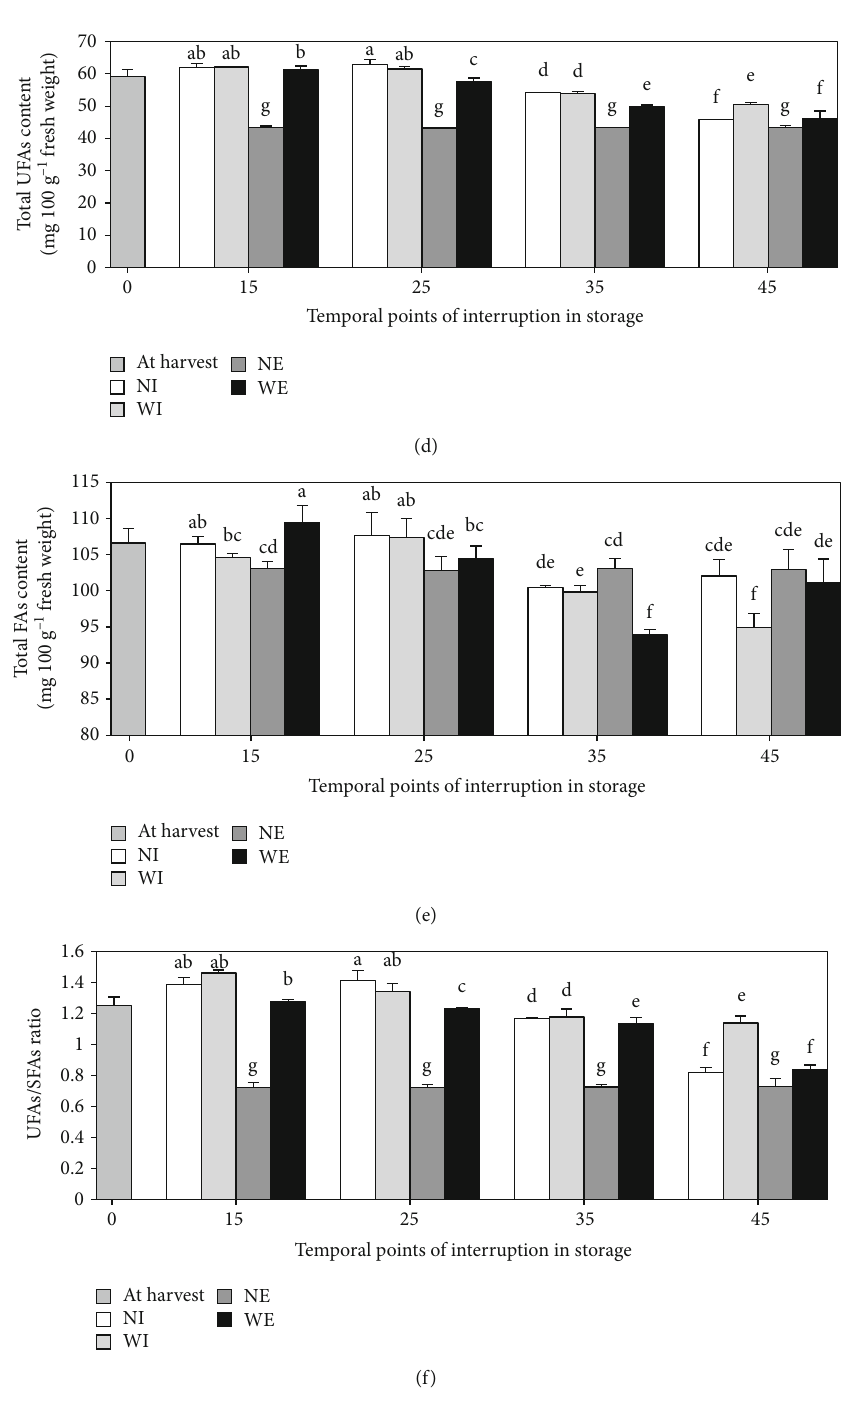
Figure 2: Modi fi cations in the total content of saturated (a), monounsaturated (b), polyunsaturated (c), and unsaturated (d) fatty acids, total fatty acids (e), and unsaturated/saturated fatty acids ratio (f) in pomegranate fruit peel during 70 days storage (at 2 ± 0.5 ° C and 90 ± 5% RH). Intermittent warming was conducted in the form of a single warming period (1 day at 20 ° C with 70% RH) before returning the treated fruit to storage. Temporal points of interruption were 15th, 25th, 35th, or 45th days of storage. WI stands for warmed fruit which were immediately sampled after warming on the date of interruption, NI stands for not warmed fruit which were sampled on the date of interruption, WE stands for warmed fruit, which were returned to storage and sampled at the end of the storage period, and NE stands for not warmed fruit sampled at the end of the storage period. Data are means of 3 replicates ± SD. All statistical di ff erences (by LSD test, P ≤ 0.05) throughout the storage period are shown in di ff erent